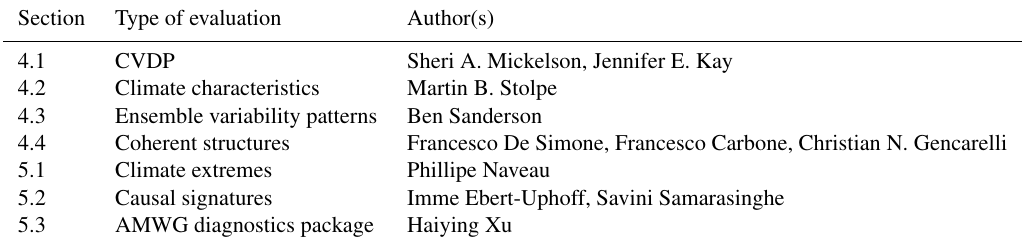
Table A1. A list of co-authors and their corresponding